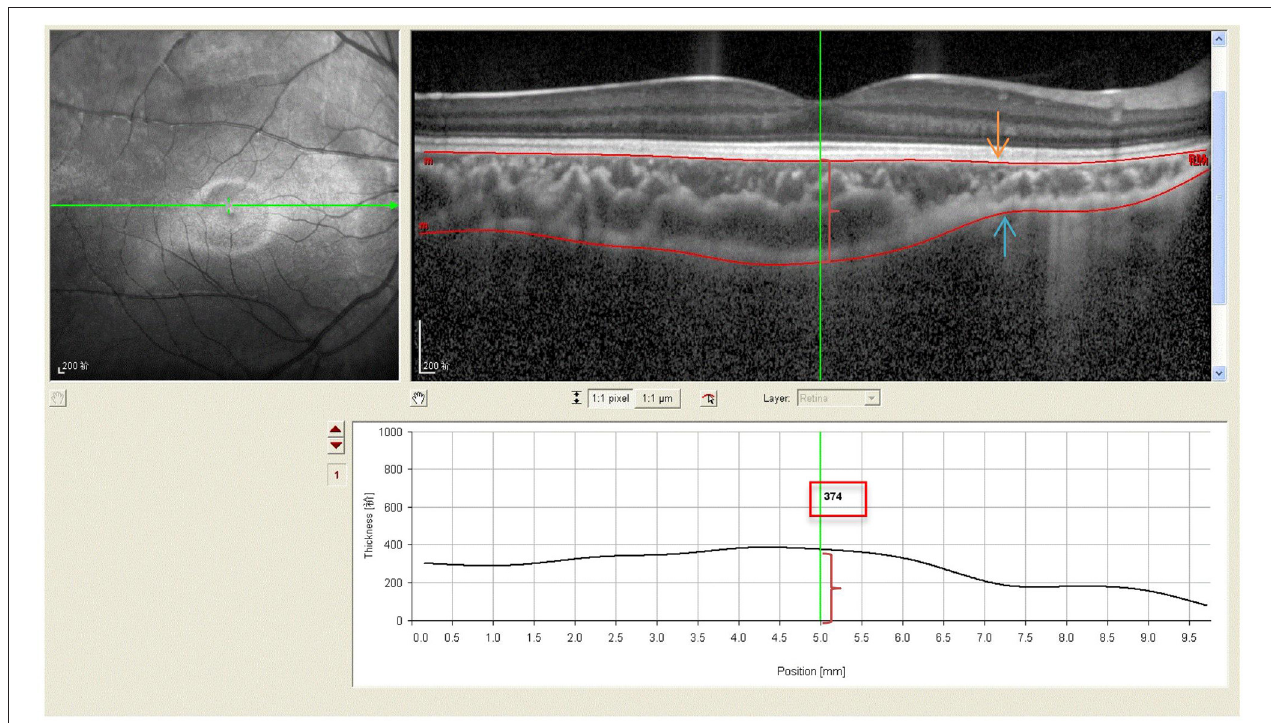
FIGURE 2 | Spectral-domain optical coherence tomography (SD-OCT) scans showing choroidal thickness of high myopic amblyopic eyes. (Top left) Fundus image showing horizontal scan lines go through the fovea in 6-year-old subject. (Top right) The choroidal thickness (red brace) was defined from the basal aspect of the RPE (redline,yellow arrow) to the outer border of the choroid (redline, blue arrow). (Bottom) The choroidal thickness 374 µ m (red brace, red boxes) was measured vertically at the subfoveal by Heidelberg own software, and at 500 µ m intervals from the fovea to 3mm nasal,